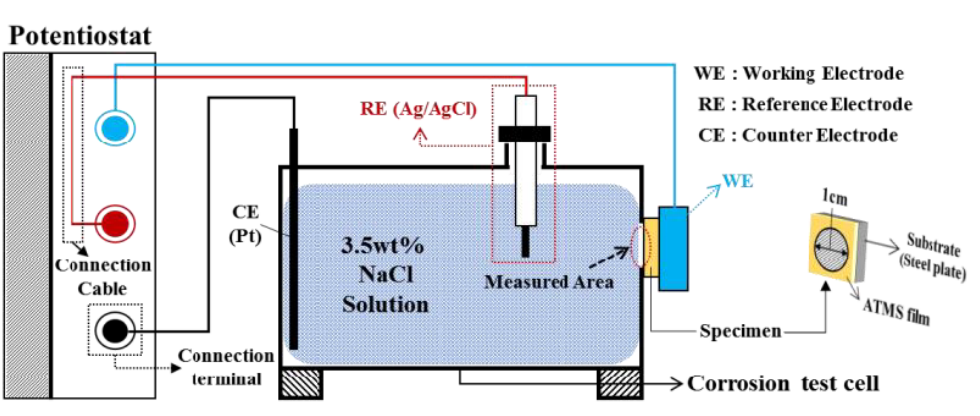
Figure 59. The schematic drawing of the experimental setup for EIS. Reprinted under Creative Commons CC BY license